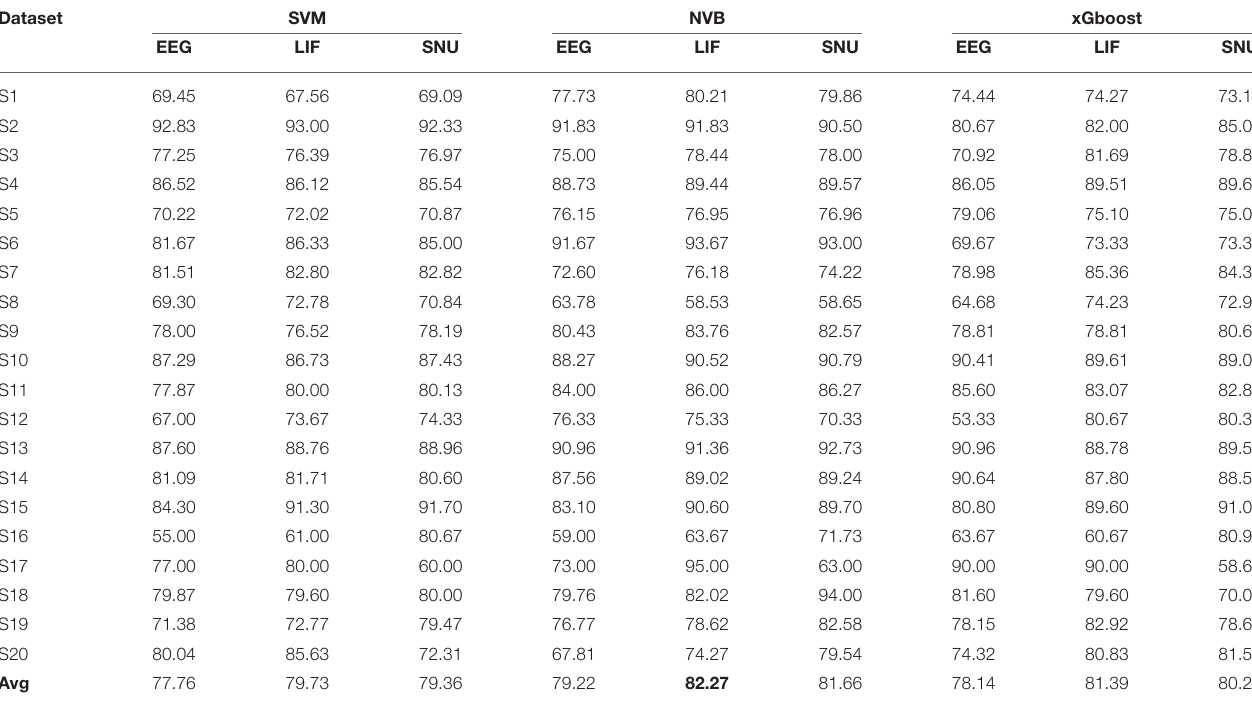
TABLE 3 | Comparison of the classification performance of ERN’s EEG signal and its spike-representation by LIF-based and SNU-based SNN using SVM, NVB, and xGboost classifiers.